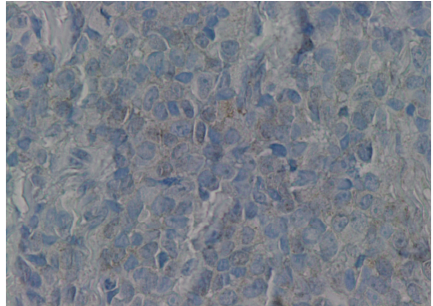
Figure 3: Neuron-specific enolase stain showing mild positivity.